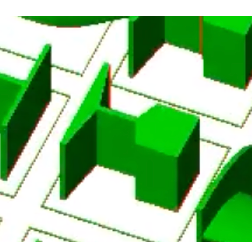
Figure 10. Shape in places 15 and 25 in IFC Viewer